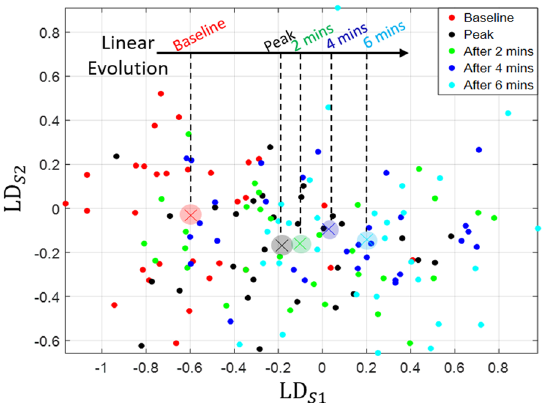
Figure 4. The trajectory of the centroid of the blood condition clusters, with images averaged over each person. The individual volunteer’s images, projected onto our DF space, are also shown, to disclose the inter-subject